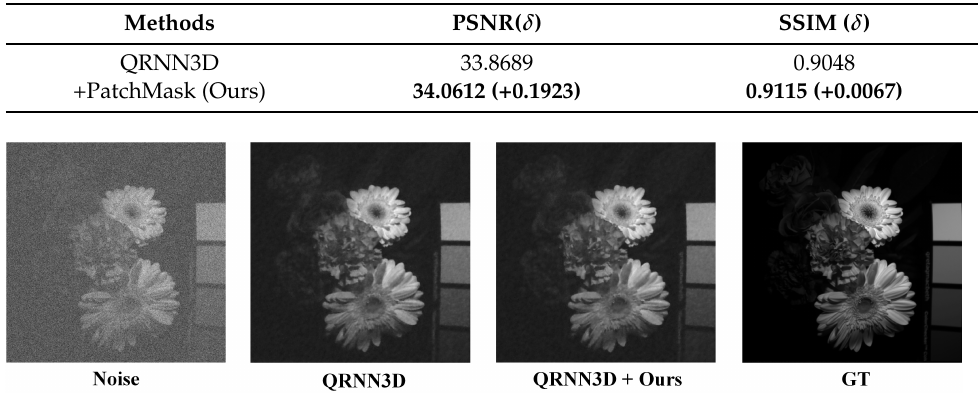
Figure 7. Presentation of the CAVE dataset. The images above were provided by the CAVE dataset [71] and are all RGB images that were rendered under neutral daylight illumination (D65). Table 2. The effect of the method was demonstrated on the CAVE dataset. Best scores are highlighted.